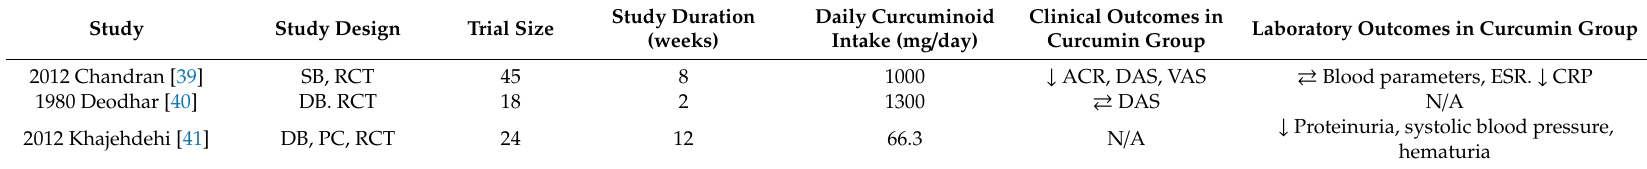
Table 4. Clinical e ffi cacy of curcumin supplementation in rheumatoid arthritis and lupus